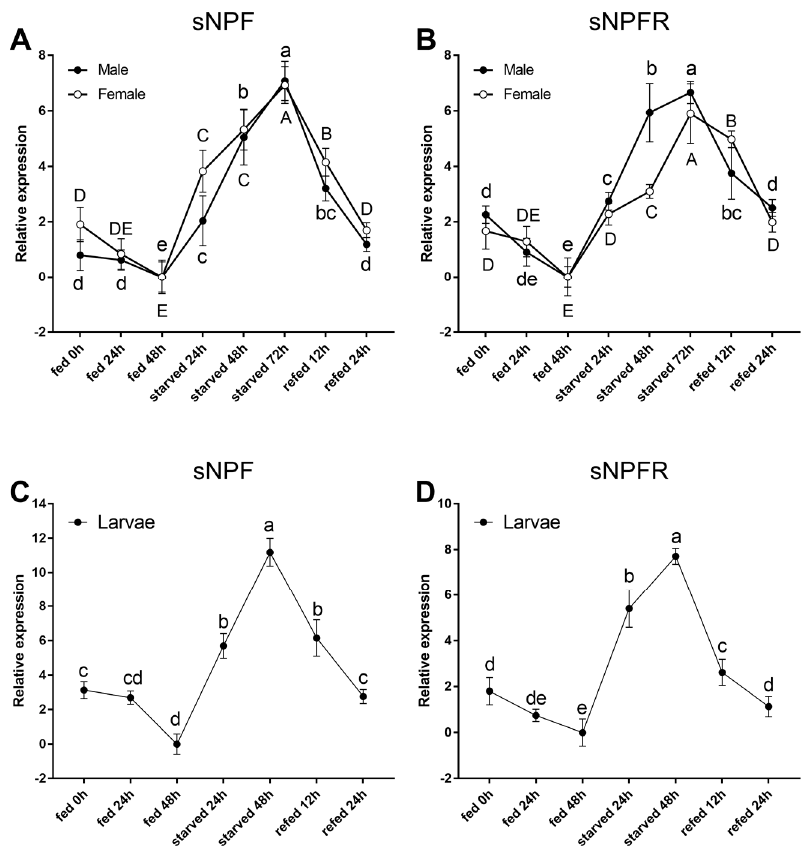
Figure 5. Relative expression levels of emerged adults of sNPF ( A ) and sNPFR ( B ), and larvae of sNPF ( C ) and sNPFR ( D ) in D. armandi after starvation and subsequent re-feeding treatment. The relative expression levels were normalized with β -actin and CYP4G55 . Different letters indicate significant differences at the 0.05 level. Tukey tests: uppercase for males, lowercase for females, and uppercase for males and larvae; no letter means no significant difference among all times. All values are mean ± SE, n = 3.